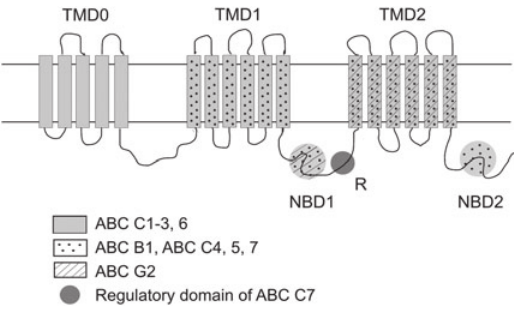
Figure 1 Schematic overlay of structural features of MDR- associated ABC